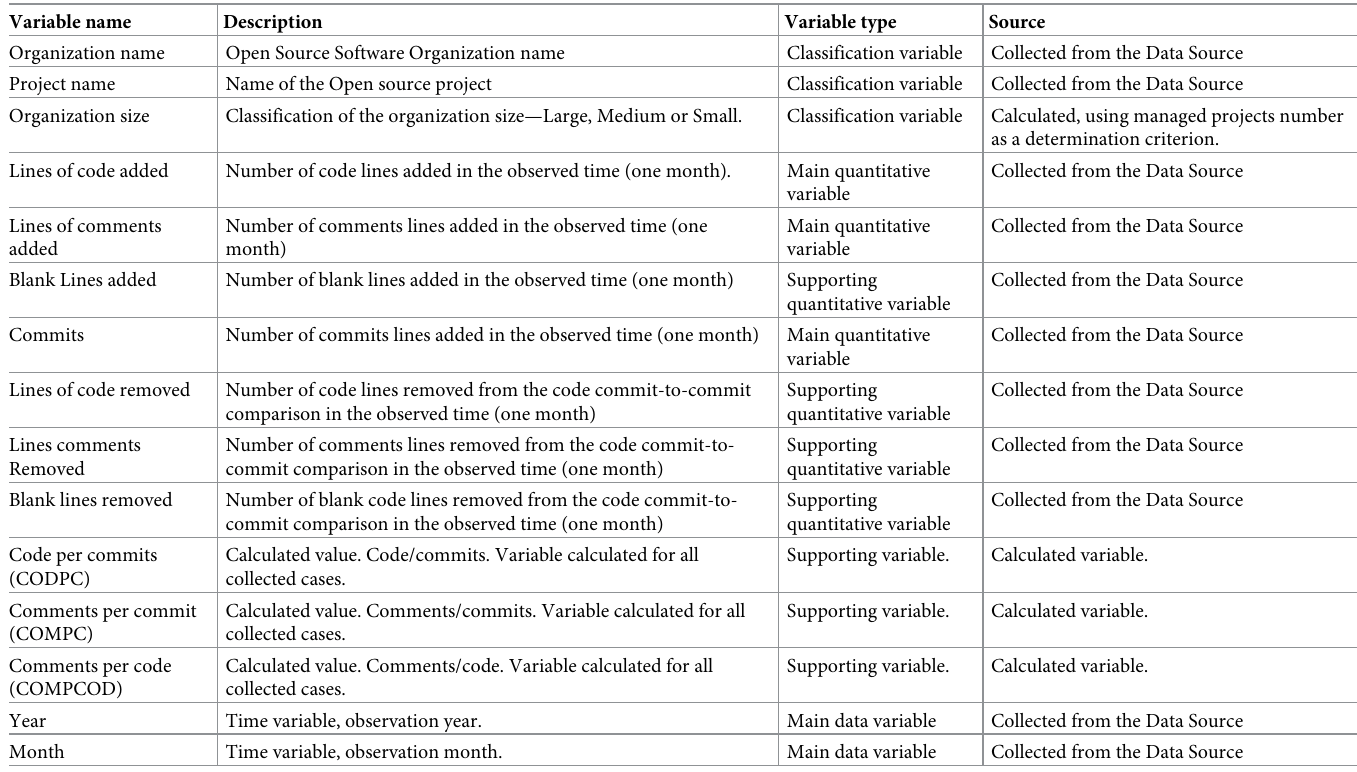
Table 1. The list of variables, with types and source classification.